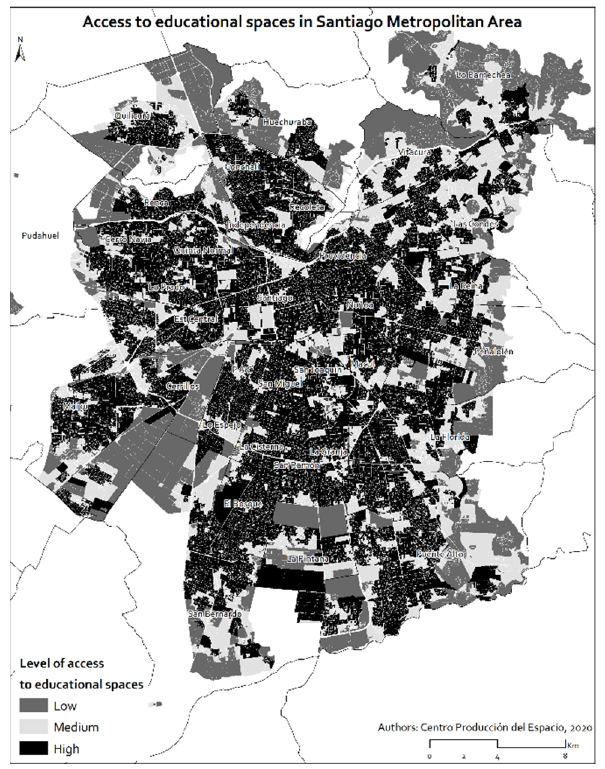
Figure 4. Access to Educational Spaces in the Santiago Metropolitan Area. Source: authors.